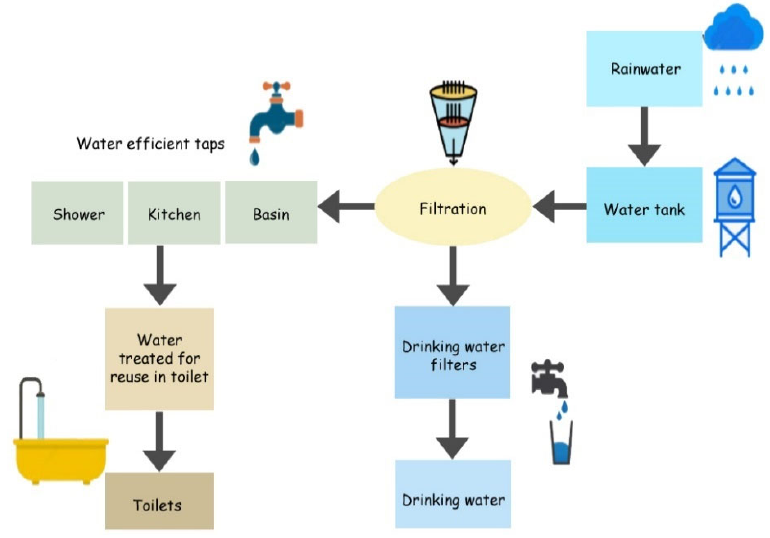
Figure 5. Greywater recycling system for the residence.